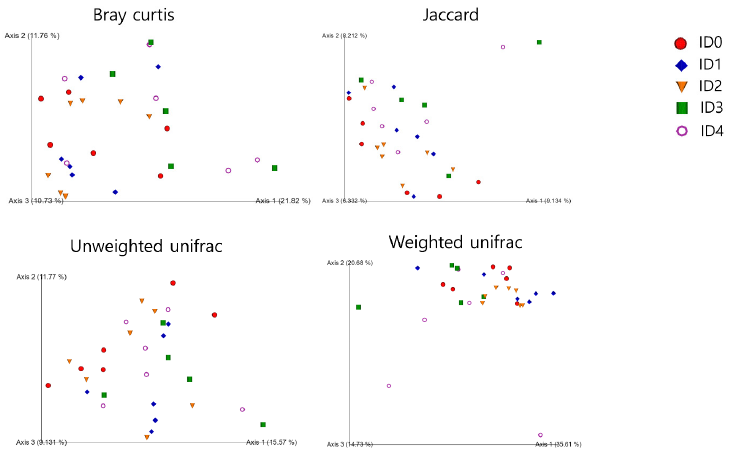
Figure 2. Effects of different infection doses of Eimeria tenella on beta diversity parameters (unweighted and weighted unifrac) of the cecal microbial communities in broilers on 6 days post-infection. Beta diversity parameters were measured in the ID0 (infection dose 0; sham-challenged with phosphate-buffered saline); ID1 (infection dose 1; challenged with 6250 sporulated oocysts of E. tenella ); ID2 (infection dose 2; challenged with 12,500 sporulated oocysts of Eimeria tenella ); ID3 (infection dose 3; challenged with 25,000 sporulated oocysts of Eimeria tenella ); ID4 (infection dose 4; challenged with 50,000 sporulated oocysts of Eimeria tenella ) groups. The infection dose groups were compared using one-way ANOVA followed by Dunnett’s post hoc test. Each infection dose group was set as the control group. *** presented when p < 0.01. Orthogonal polynomial contrast analysis was used to assess linear (L) and quadratic (Q) effects of the infection doses, and p < 0.1 were presented.